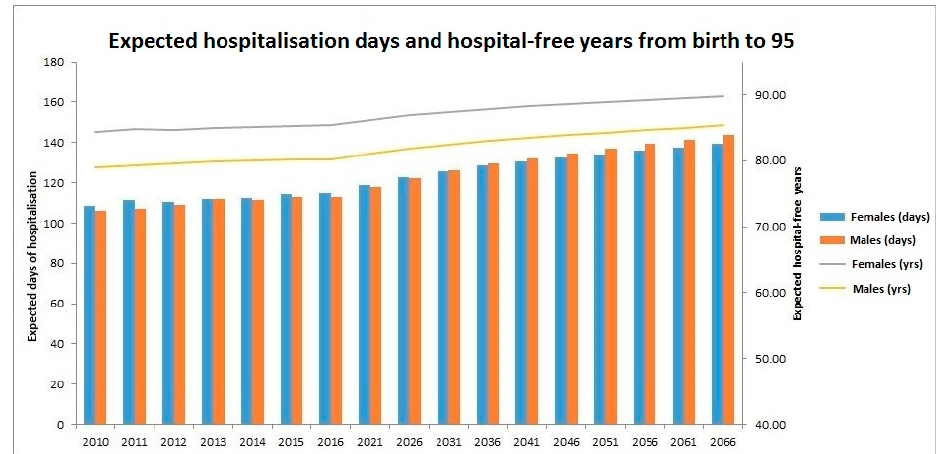
Figure 5. Percentages of the LOS by age group column chart. Int. J. Environ. Res. Public Health 2018 , 15 , x